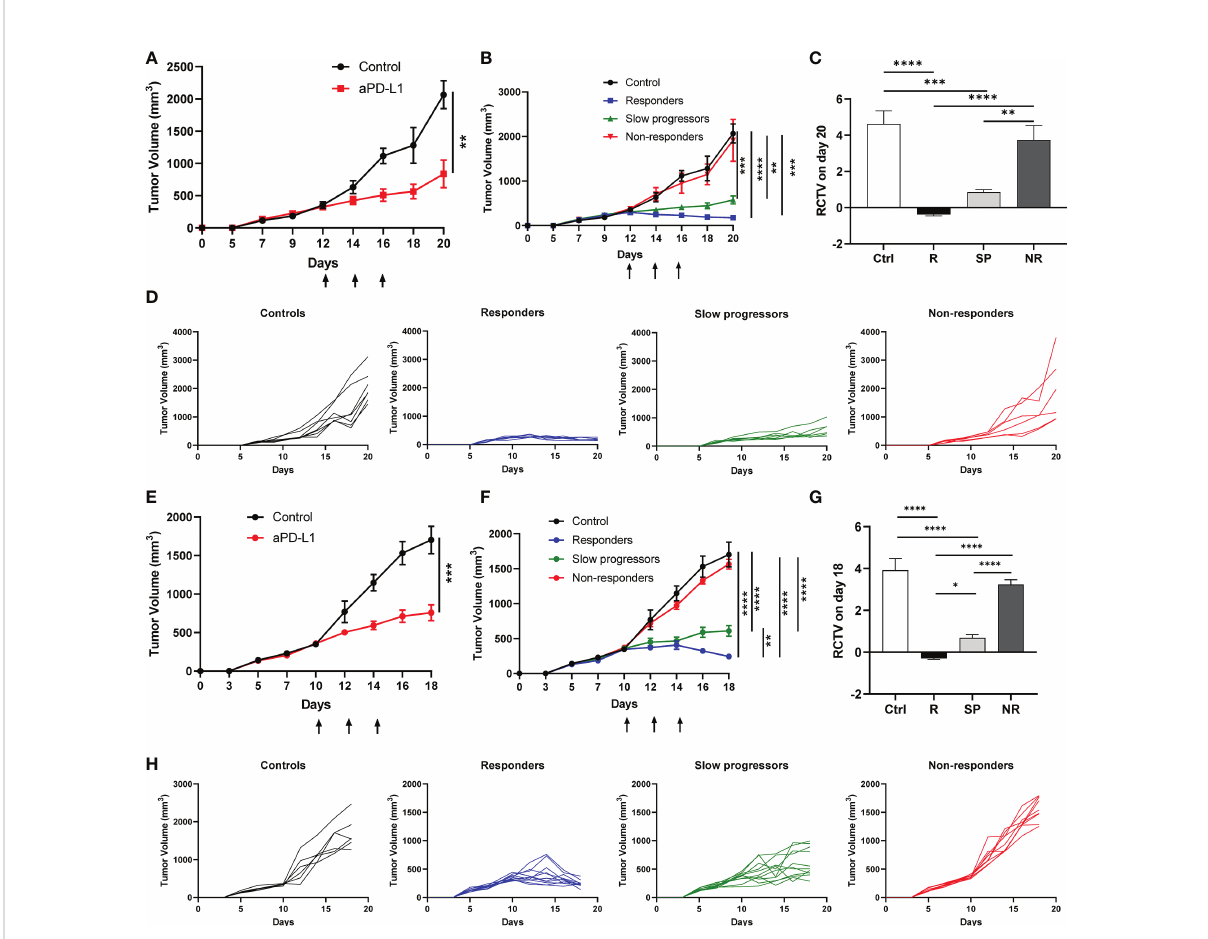
FIGURE 1 Differential responses to anti-PD-L1 treatment in A223 tumor-bearing mice. (A – D) A223 tumor cells (1×10 5 ) were injected s.c. into one fl ank of WT B6 mice (n=30, 90% take rate). Tumor-bearing mice were randomized and treated with control or anti-PD-L1 Ab at day 12 (arrows indicate treatment days) after tumor injection. Tumor growth was monitored for 20 days. (A) Overall tumor growth curves of control (n=7) and anti-PD- L1-treated (n=20) mice. (B) Tumor growth curves of control, R, SP and NR groups. According to RCTV on day 20, anti-PD-L1 treated recipients diverged into R (n=7, RCTV<0), SP (n=7, 0<RCTV ≤ 1.5) and NR (n=6, RCTV>1.5). (C) RCTV of control and different treatment groups (R, SP and NR) calculated as (TV day20 -TV day12 )/TV day12 . (D) Individual tumor growth curves of control, R, SP, and NR groups. (E – H) A223 tumor cells (1×10 5 ) were injected into the buccal region (cheek) of WT B6 mice (n=41, 90% take rate). Tumor-bearing mice were randomized and treated with control or anti-PD-L1 Ab at day 10 (arrows indicate treatment days) after tumor injection. Tumor growth was monitored for 18 days. (E) Overall tumor growth curves of control (n=6) and anti-PD-L1-treated mice (n=31). (F) Tumor growth curves of control, R, SP and NR groups. According to RCTV on day 18, anti-PD-L1 treated recipients diverged into R (n=11, RCTV<0), SP (n=11, 0<RCTV ≤ 1.5) and NR (n=9, RCTV>1.5). (G) RCTV of control and different treatment groups (R, SP and NR) calculated as (TV day18 -TV day10 )/TV day10 . (H) Individual tumor growth curves of control, R, SP, and NR groups. Data were presented as mean ± SEM. Statistical signi fi cance was calculated with unpaired t test or one-way ANOVA followed by Tukey ’ s multiple comparisons test (* P <0.05; ** P <0.01; *** P <0.001; **** P